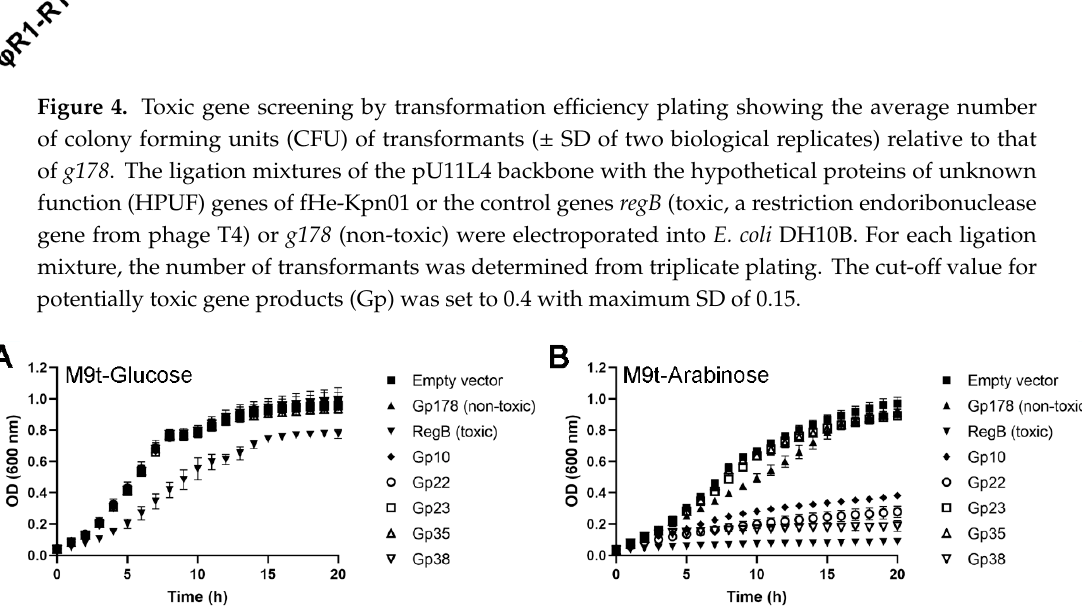
Figure 5. Growth curves of E. coli DH5 α expressing the indicated gene products (Gp) under the arabinose-inducible promoter of pBAD33 in M9t minimal medium supplemented with repressing glucose ( A ) or inducing arabinose ( B glucose ( A ) or inducing arabinose ( B ).